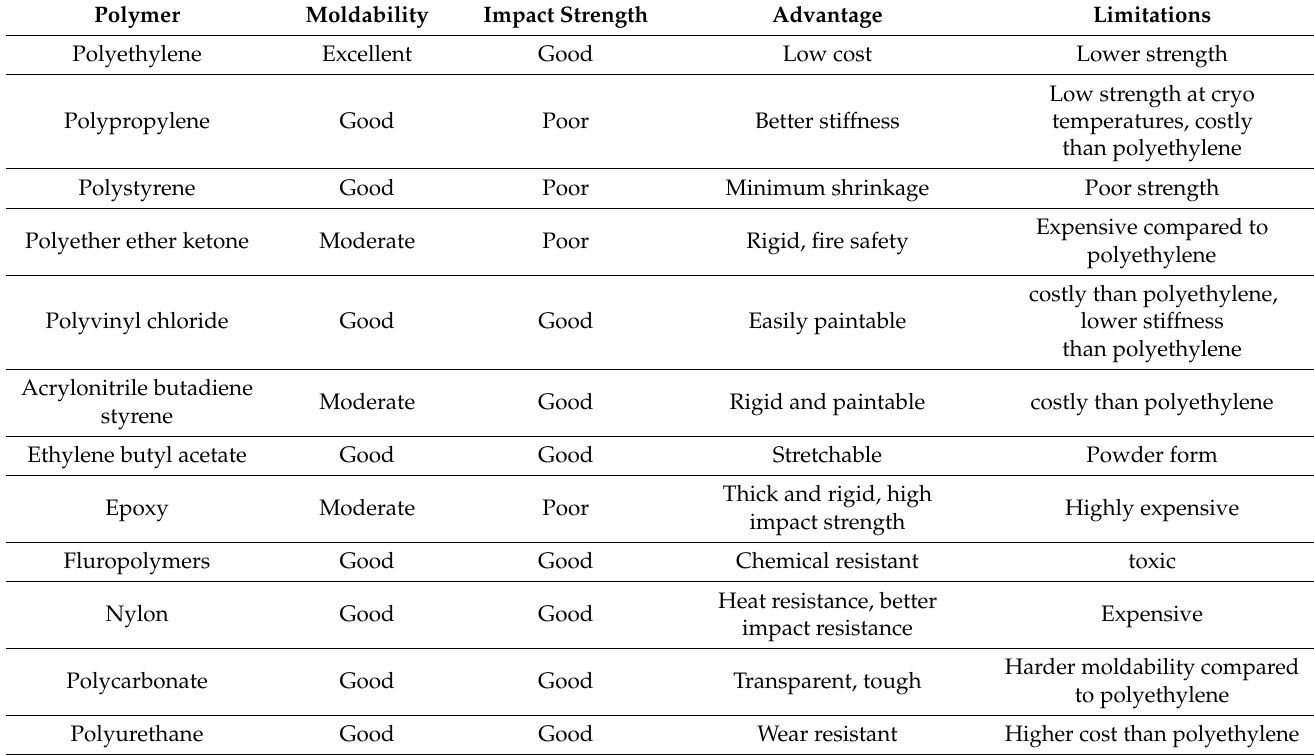
Table 4. Various polymers and their properties needed for rotomolding [142,143].